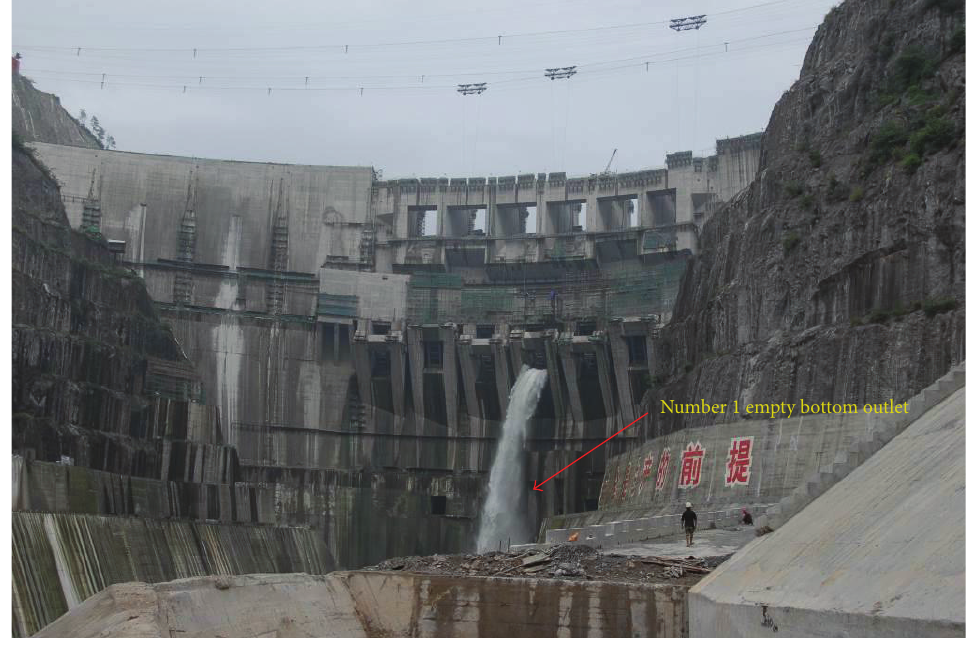
Figure 1: Distribution of the outlets of the Goupitan arch